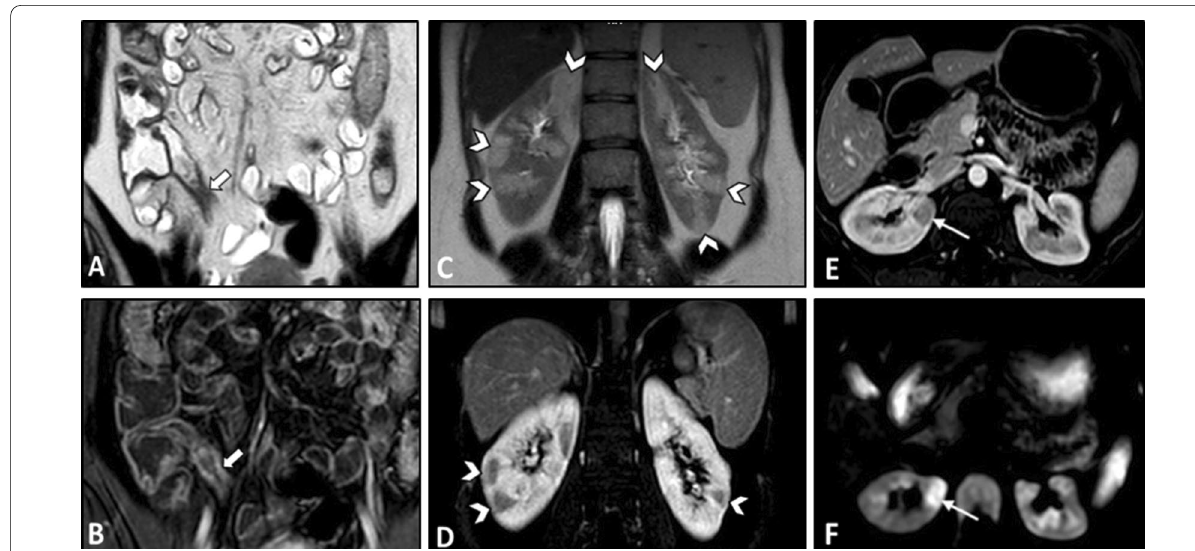
Fig. 7 Intestinal vasculitis in a 39-year-old female presenting with episodic abdominal pain and findings of non-specific terminal ileitis in ileocolonoscopy examination. MRE was obtained. Coronal T2-W and post-contrast T1-W images ( A , B ) display mild mural thickening and hyperenhancement at distal terminal ileum (thick white arrows). Coronal T2-W and post-contrast T1-W images ( C , D ) reveal multiple peripheral wedge-shaped hyperintense areas at both kidneys, showing decreased enhancement on delayed phase (white arrowheads). Axial post-contrast T1-W and corresponding DWI images ( E , F ) show a hypoenhancing lesion at the right renal cortex with diffusion restriction (thin white arrows). Vasculitis was suspected as the underlying cause. Afterward, positive results for antineutrophil cytoplasmic antibody (ANCA) and inflammatory markers were consistent with the diagnosis of ANCA-associated vasculitis